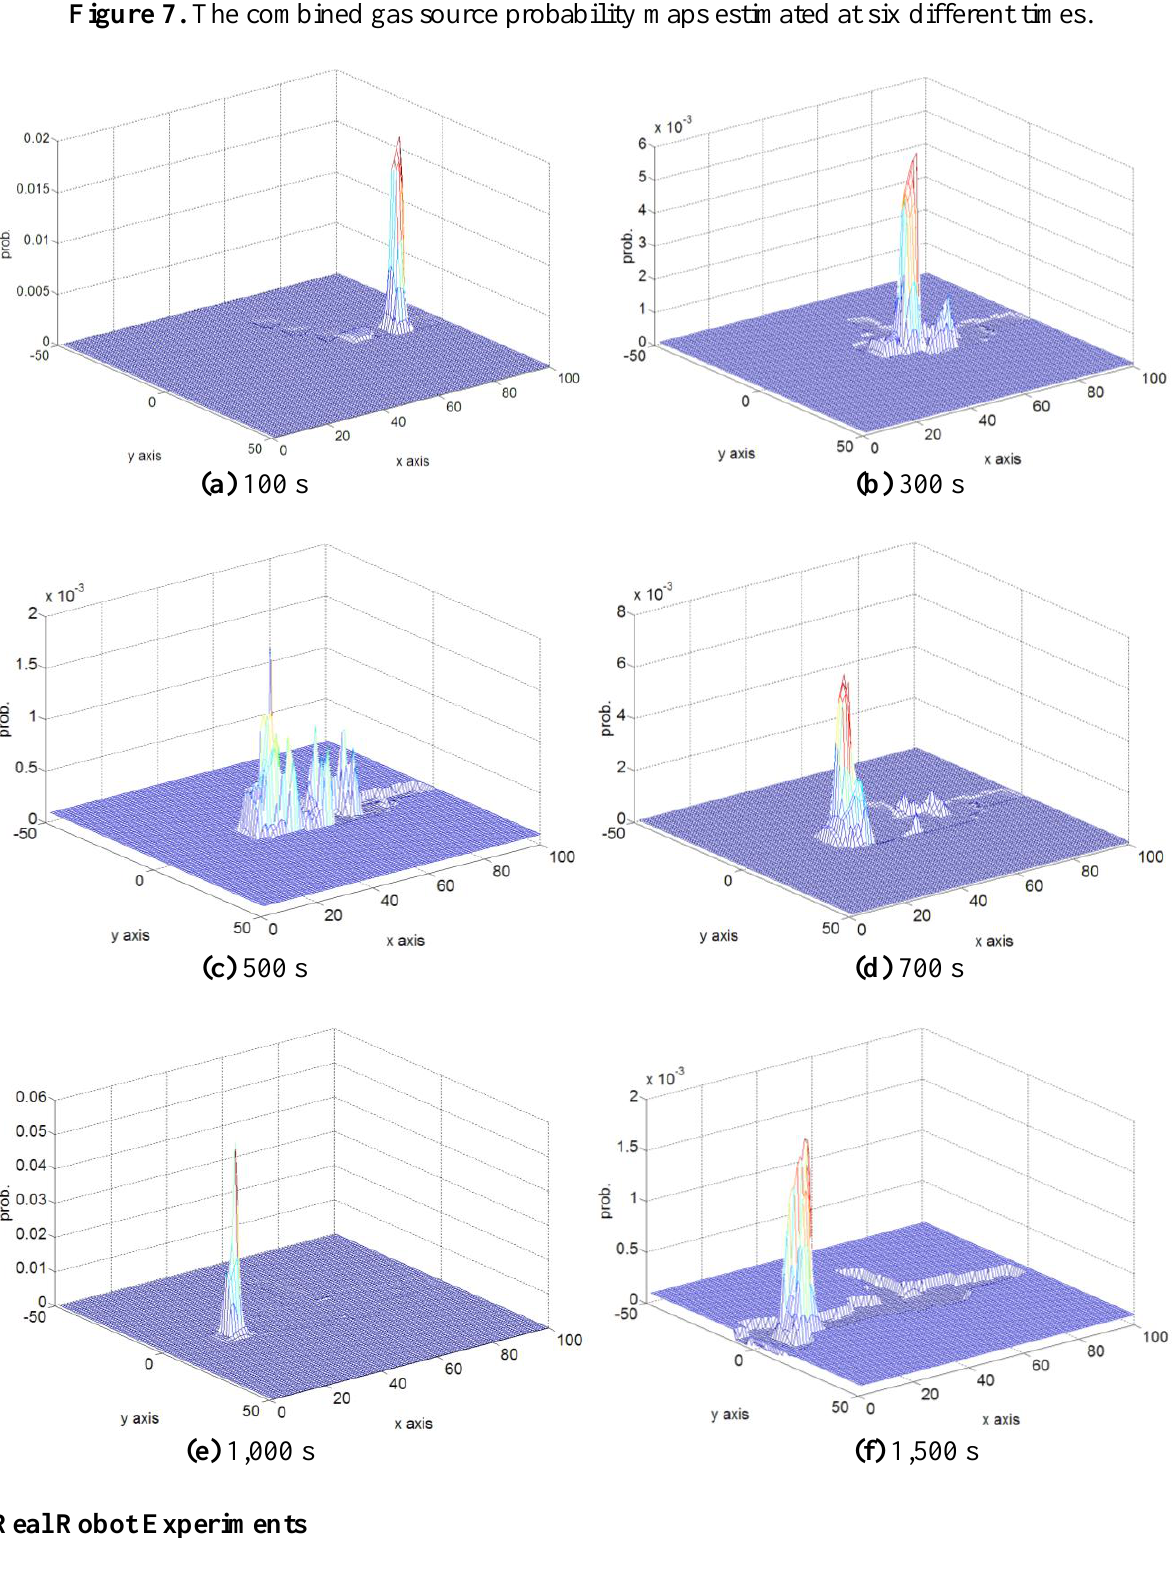
Figure 7. The combined gas source probability maps estimated at six different